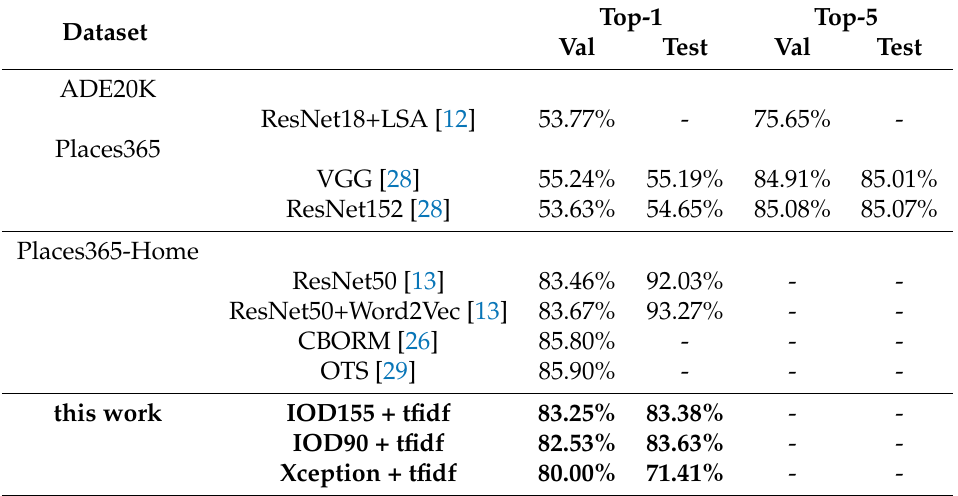
Table 2. Scene Recognition—Model Comparisons (IOD90 & IOD155 conf. thresh =